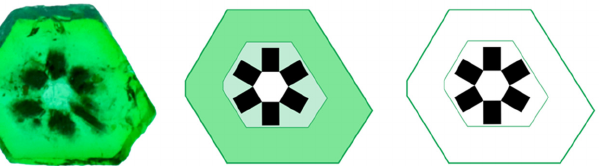
Figure 3. The illustration of the trapiche emerald in this study comprises four parts: green rim, light green color zoning, six black arms, and one nearly colorless hexagonal core.